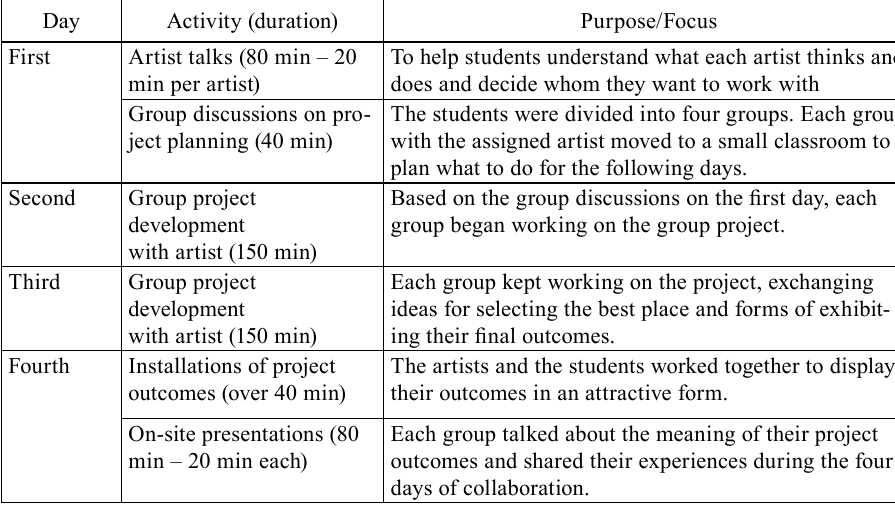
Table 3. structure of the project. (created by author)